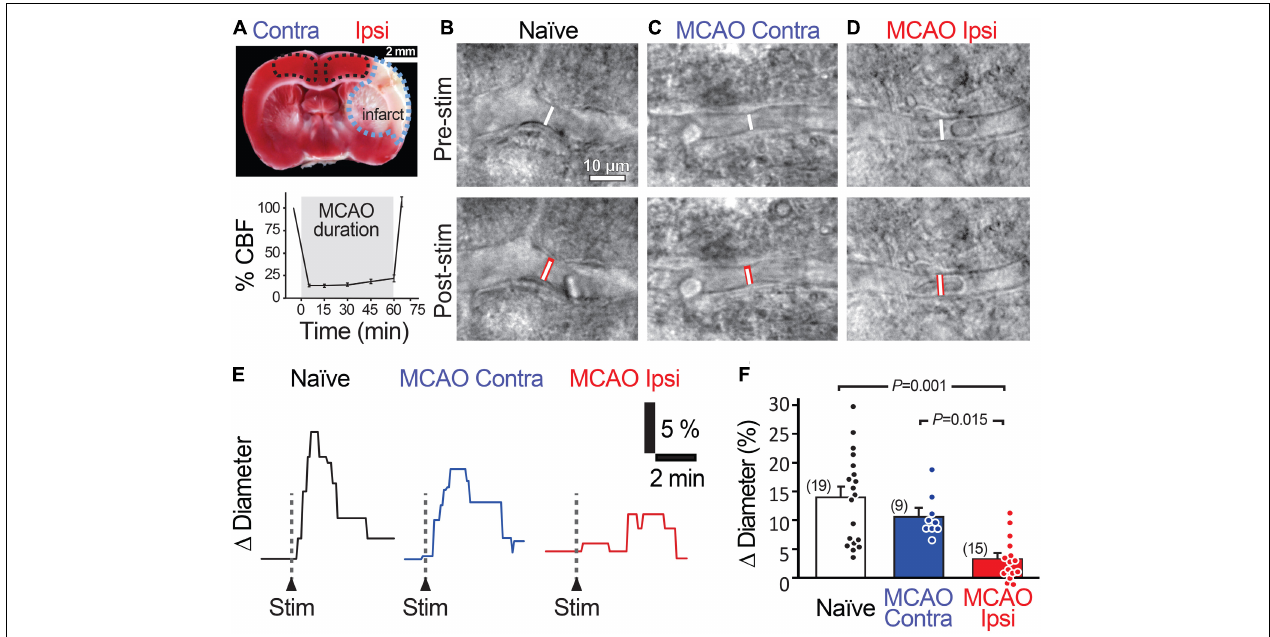
FIGURE 1 | Stimulation-evoked capillary dilation is reduced in the peri-infarct cortex after MCAO. (A) TTC staining (top) of a coronal brain slice 1 day following 60 min MCAO showing the unstained infarcted region in white (outlined in blue) and intact tissue in red. MCAO Ipsi data were acquired from the peri-infarct cortical region and contralateral hemisphere and naïve brain slice data were acquired in the analogous region (outlined in black). Bottom graph shows the decrease in cerebral blood flow (CBF) in the MCA territory during occlusion. An example capillary in naïve (B) , MCAO Contra (C) , and MCAO Ipsi (D) cortex before (top) and after (bottom) neuronal stimulation. Dotted white lines show capillary diameter in U46619 prior to stimulation, while the underlaid red bars in lower panels show capillary diameter after stimulation. Example traces (E) and summary quantification (F) demonstrating the reduction in stimulation-evoked capillary dilation in the MCAO Ipsi peri-infarct cortex. P -values were obtained from ANOVA followed by Tukey’s HSD test. Number in parentheses above each bar indicates N .